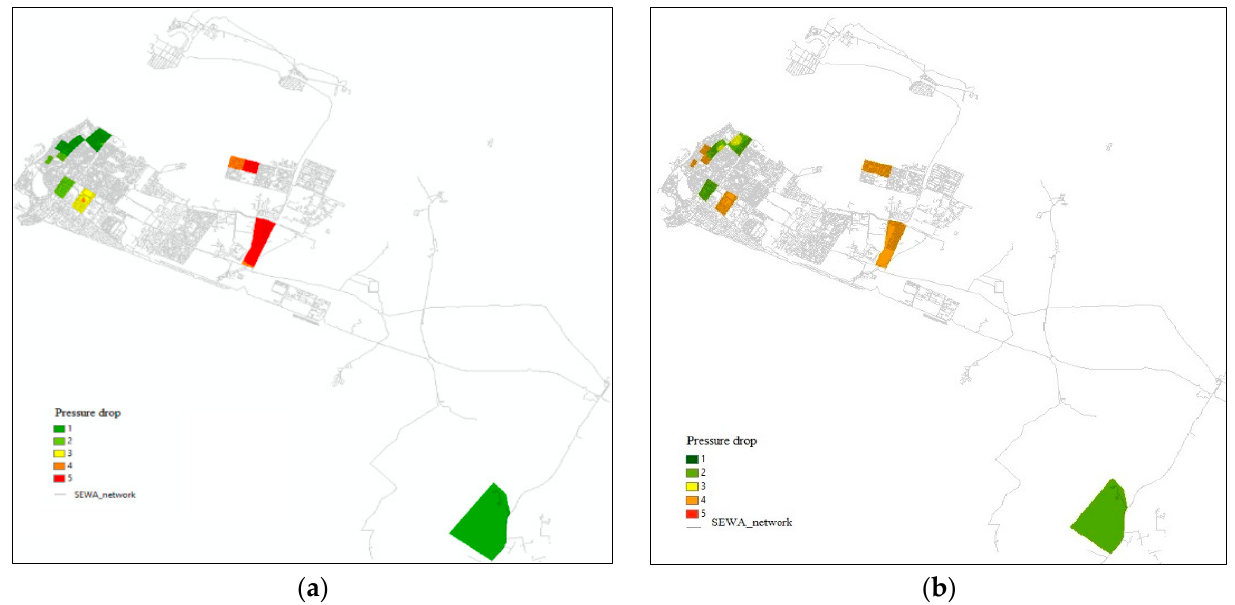
Figure 7. Pressure drops maps. ( a ) Highest pressure drop; ( b ) lowest pressure drop.